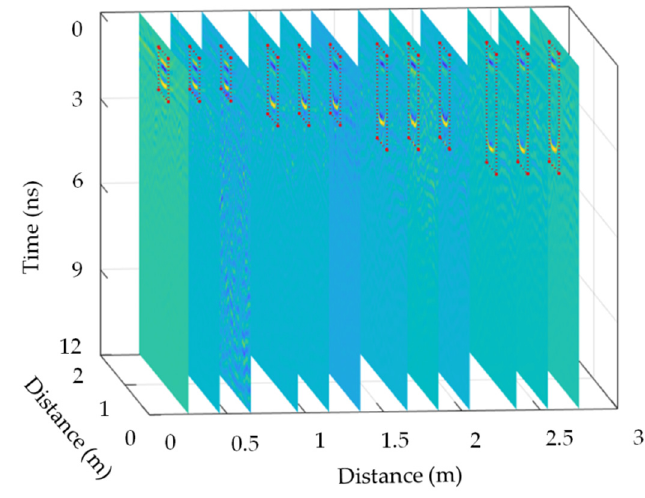
Figure 10. Slice chart formed by twelve horizontal survey lines.